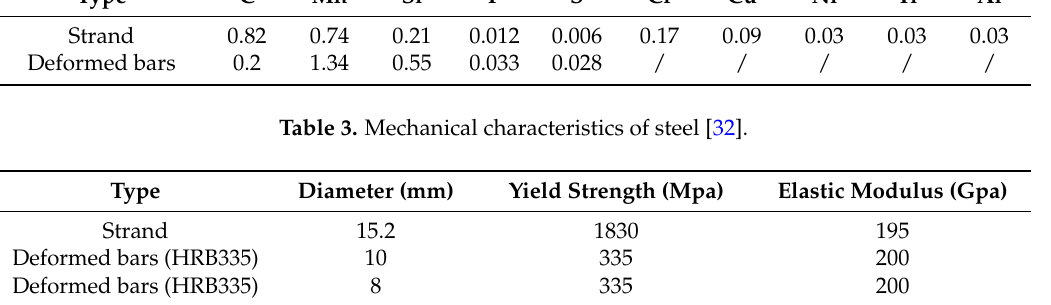
Table 4. Concrete mix proportion.